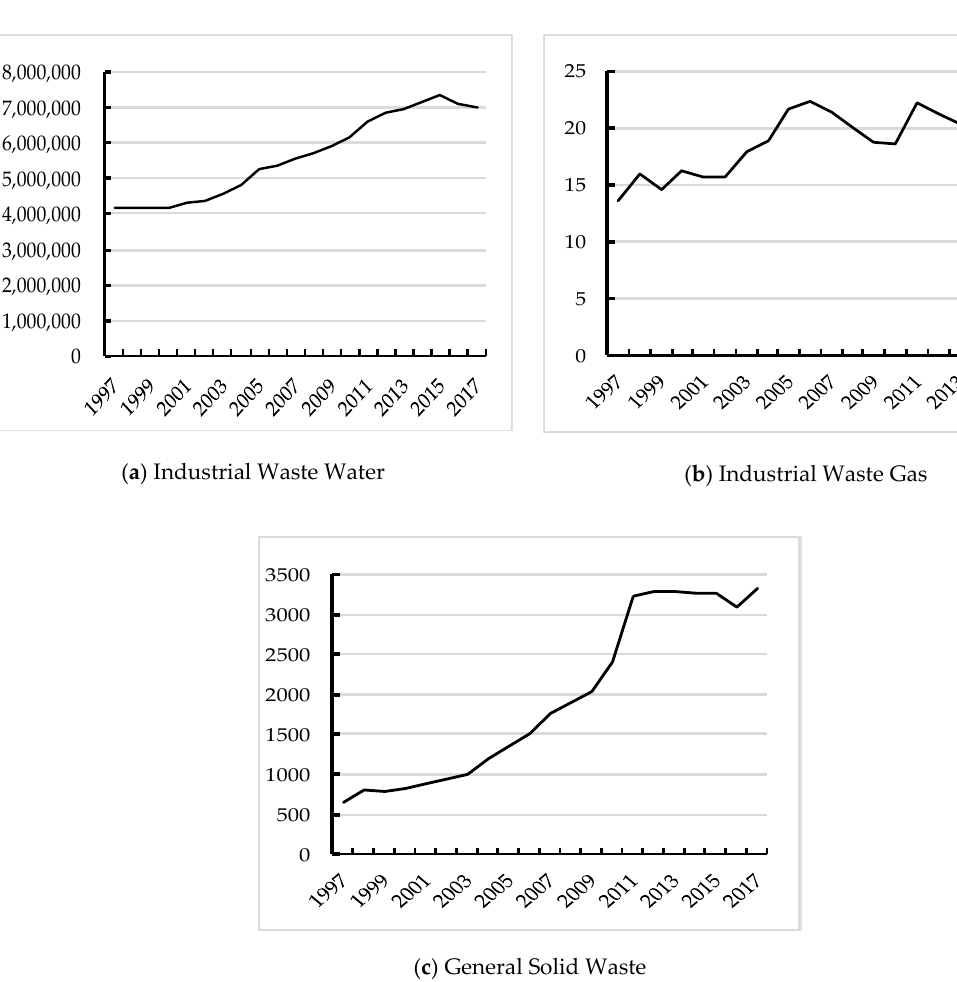
Figure 1. Change trend of the three industrial wastes in 1997–2017. (y-axis unit: million tons) (Since the emission of industrial waste gas is only counted to 2010 in the China Statistical Yearbook, the emission of main pollutants in the waste gas starts in 2011. In order to ensure the consistency of data, the emission of industrial sulfur dioxide is used as the alternative indicator for the emission of industrial waste